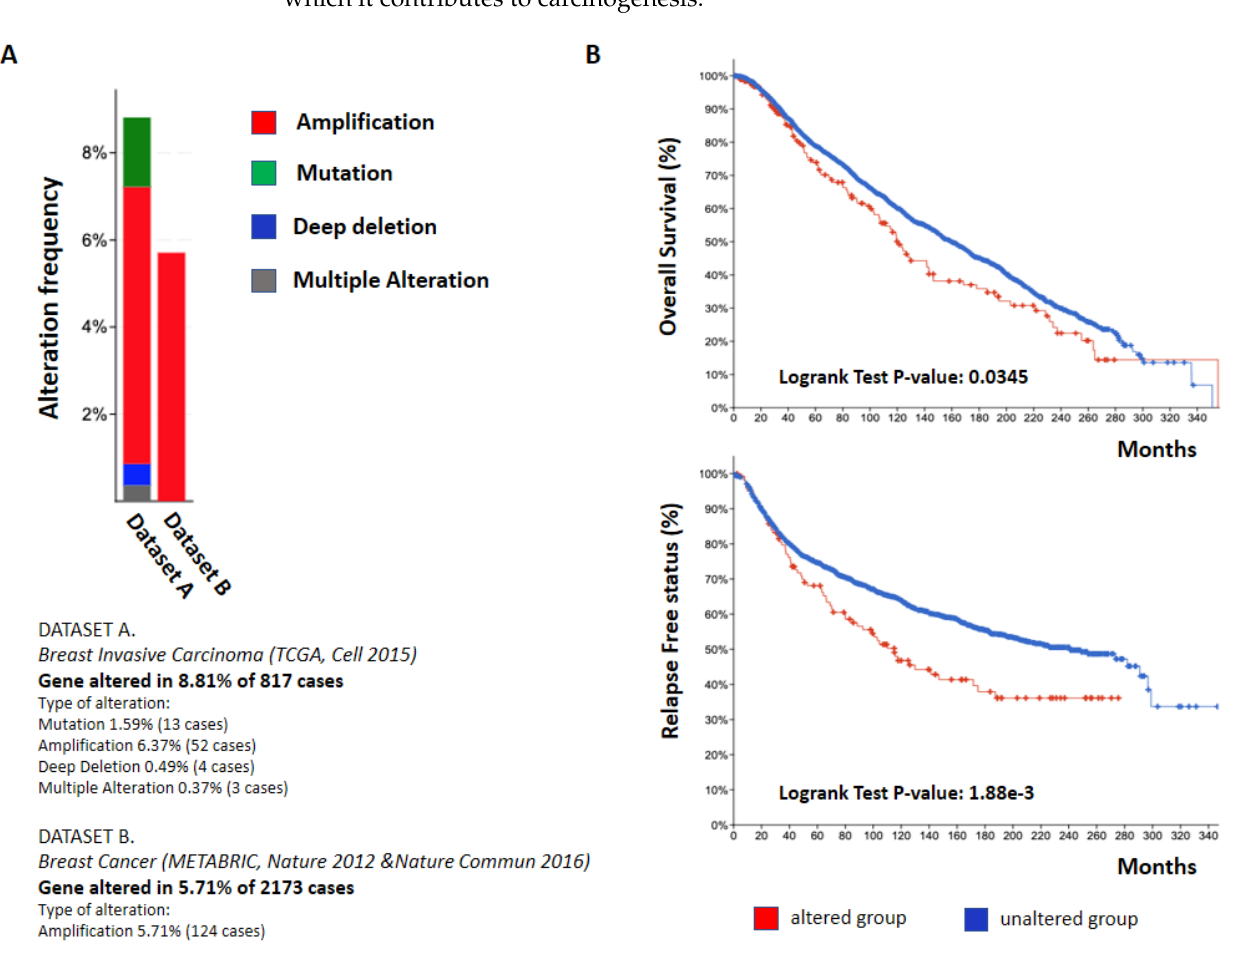
Figure 2. Analysis of ODZ4 genomic alterations in breast cancer patients: ( A ) ODZ4 alteration frequency observed by analyzing two breast cancer data sets: TCGA (Dataset A) and Metabric (Dataset B). The analyses were performed using the cBioPortal tool (www.cbioportal.org, accessed on 30 November 2021), an open-access, open-source resource for interactive exploration of multidimensional cancer genomics data sets. ( B ) Overall survival (upper panel) and relapse free status (lower panel) of breast cancer patients that displayed unaltered ODZ4 (blue line) and genomic ODZ4 alterations (red line). Statistical analysis was performed using the Log Rank Test.